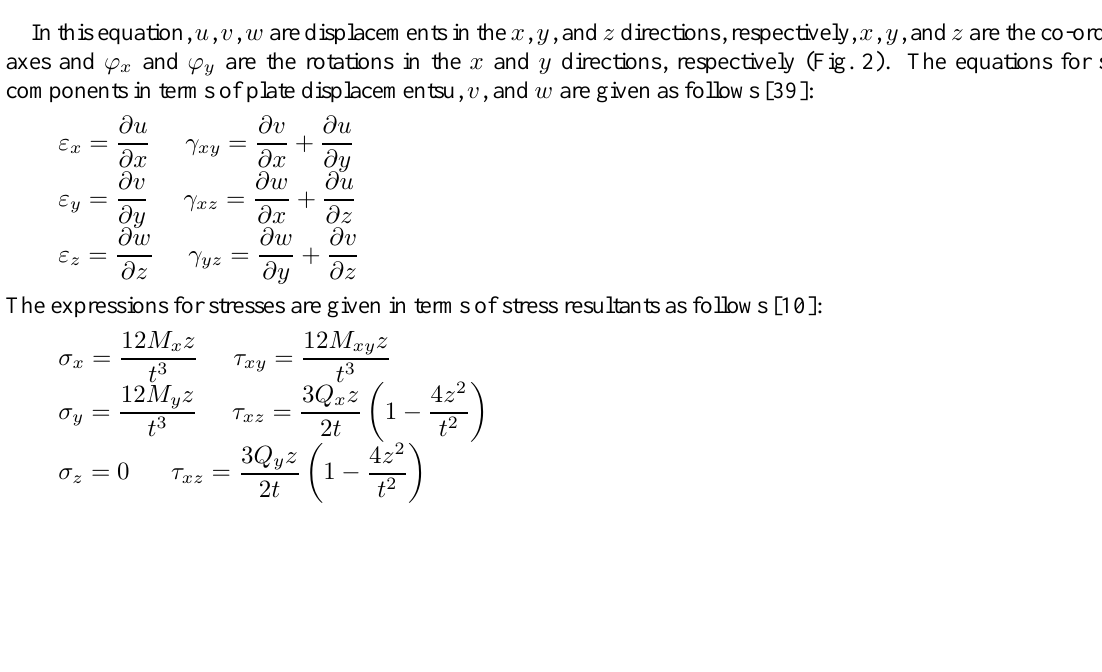
Fig. 2. 8-noded quadrilateral finite element used in this study